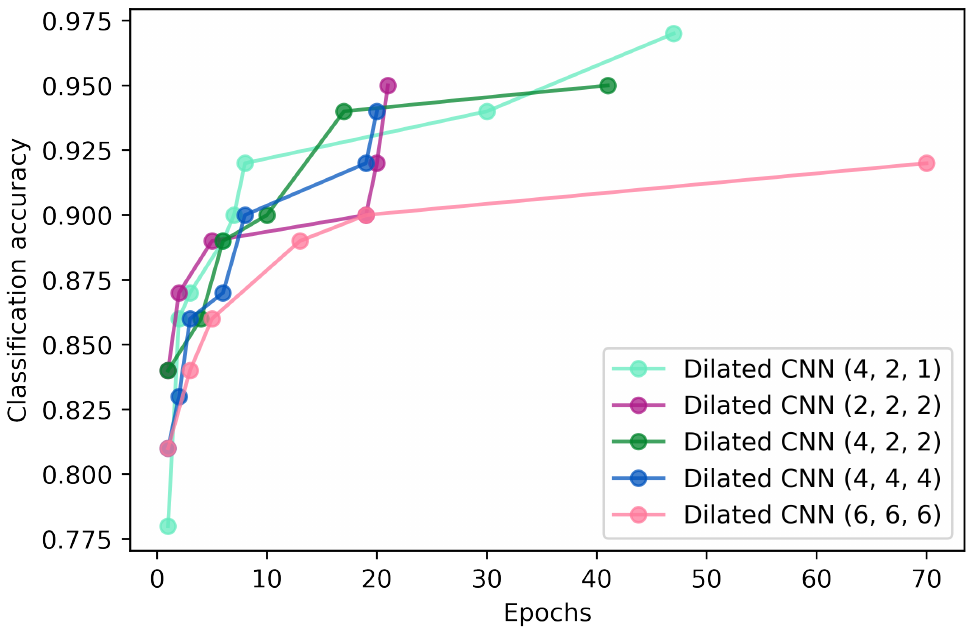
Figure 5. Performance comparison between the best Dilated CNN, Basic CNN and Simple ANN with Dropout architectures with respect to classification accuracy.